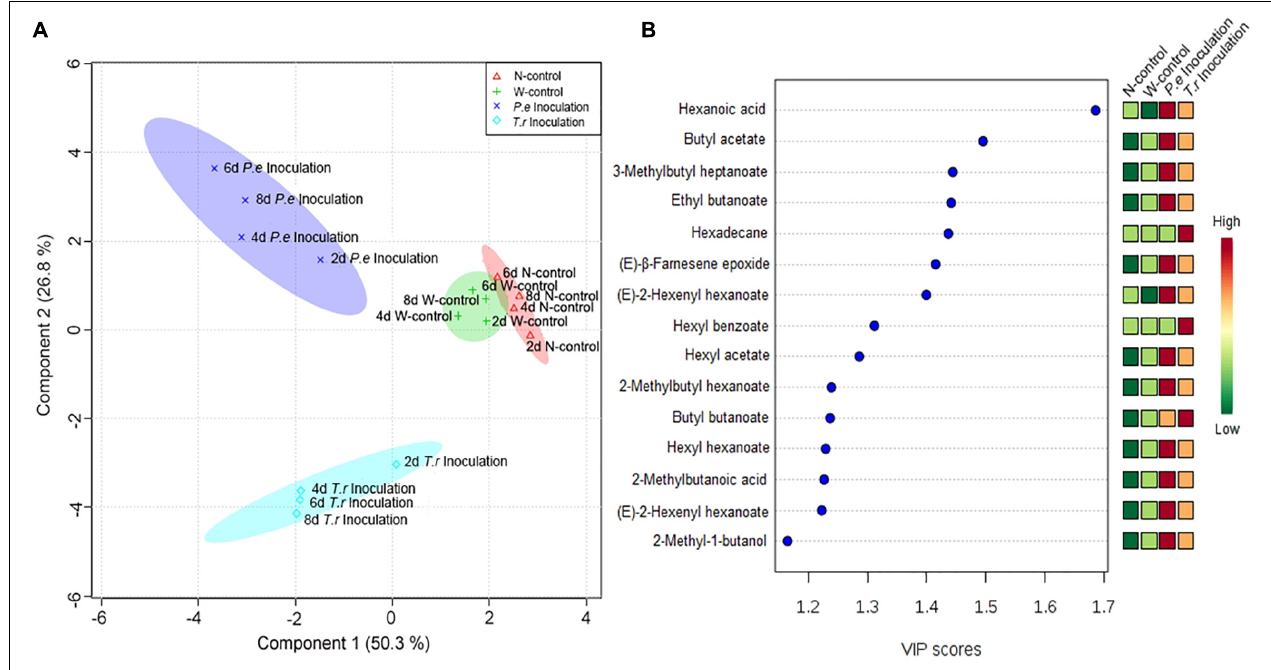
FIGURE 7 | PLS-DA analysis (A) and associated VIP score (B) were observed in the PLS-DA models of apple fruit during storage. (A) Score-plot of PLS-DA analysis according to identified volatiles in apple fruits. The markers with different shapes represent volatile samples of apple fruits from different treatments. Different color spaces represent a group and show every 2 days variation in four treatments apple fruit. (B) VIP score cut-off at